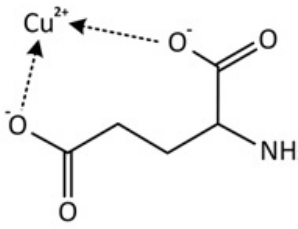
Figure 5 - Complex L-Glutamate- Cu (II) at pH 10 with neutral electric